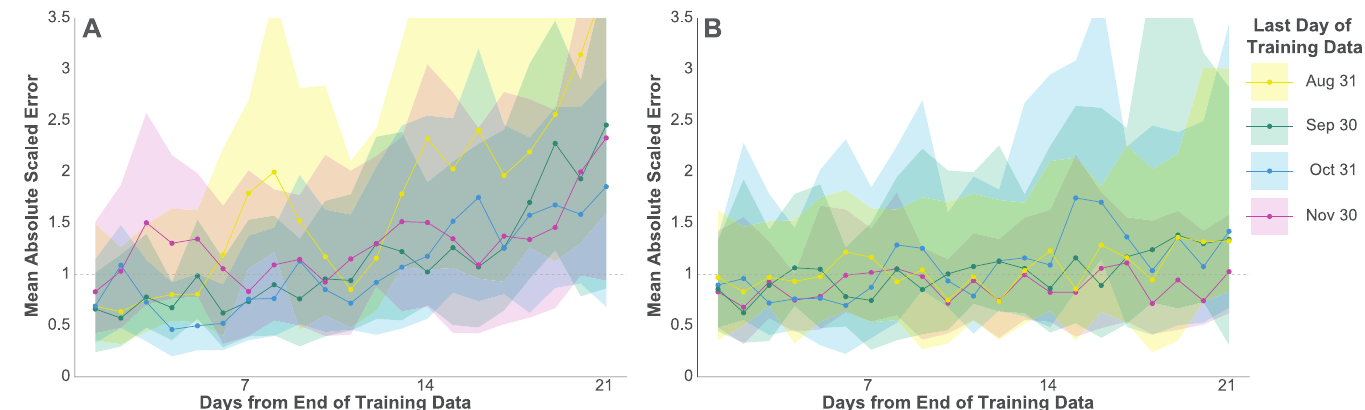
Fig 4. Predictive accuracy. The median and interquartile range (IQR) of MASE across all 50 states on each day of the 21-day prediction periods for new confirmed cases (a) and deaths (b). A MASE of 1 indicates equivalent accuracy to a one-day random walk forecast in the training data.